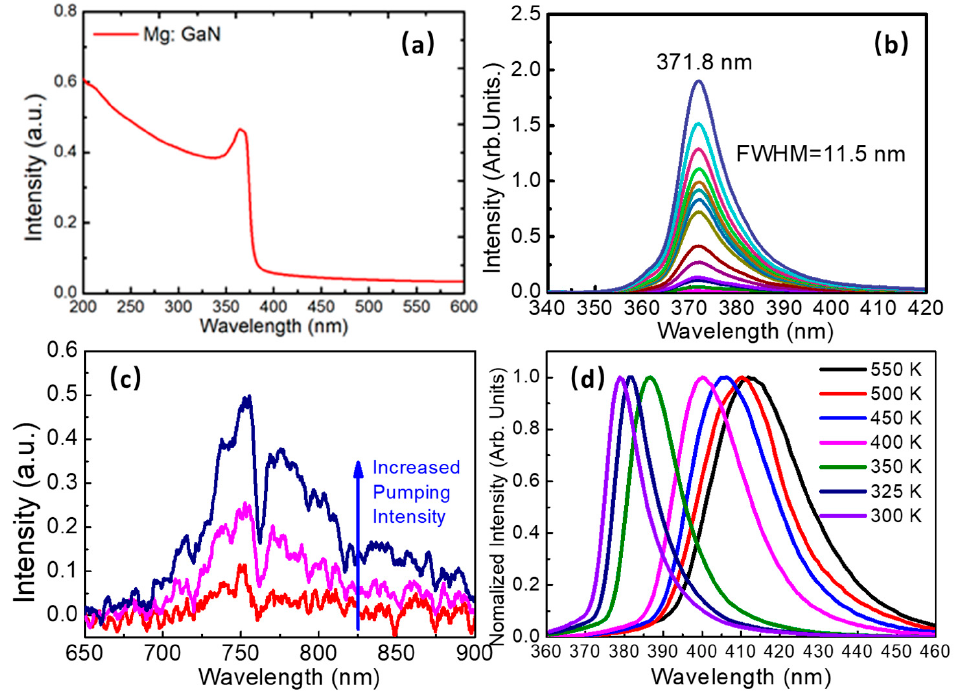
Figure 2. ( a ) Absorption spectrum of the Mg-doped GaN thin film; ( b ) Photoluminescence spectra of the Mg-doped GaN thin film excited by the 355 nm nanosecond laser; ( c ) Defect luminescence of the Mg-doped GaN thin film; ( d ) Temperature-dependent photoluminescence of the Mg-doped GaN thin film.